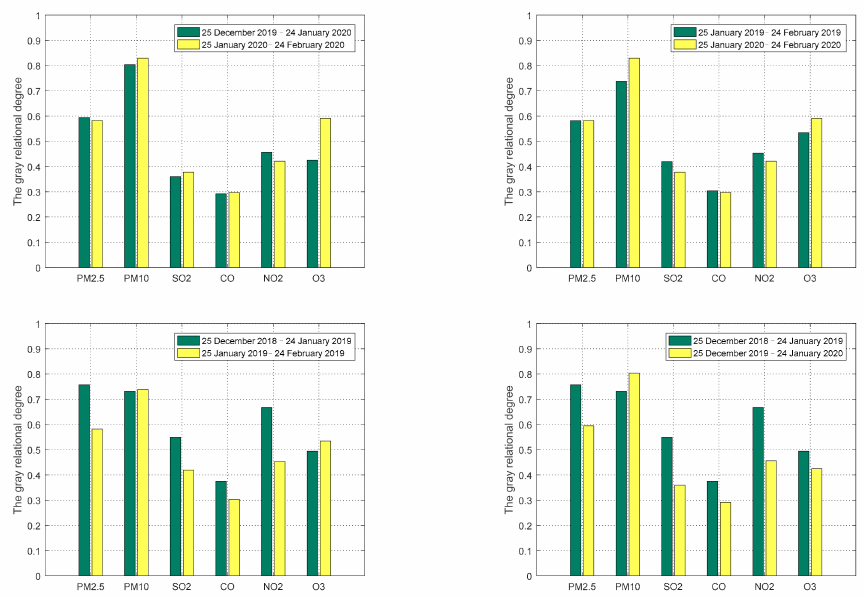
Figure 5. Comparison of the gray relational degree between pollutants and AQI in different periods of